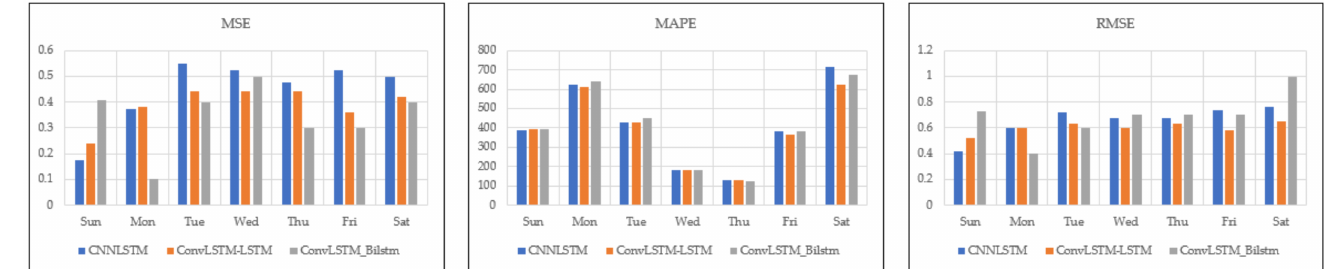
Figure 15. Evaluation metrics for different days in a week with NYISO electricity